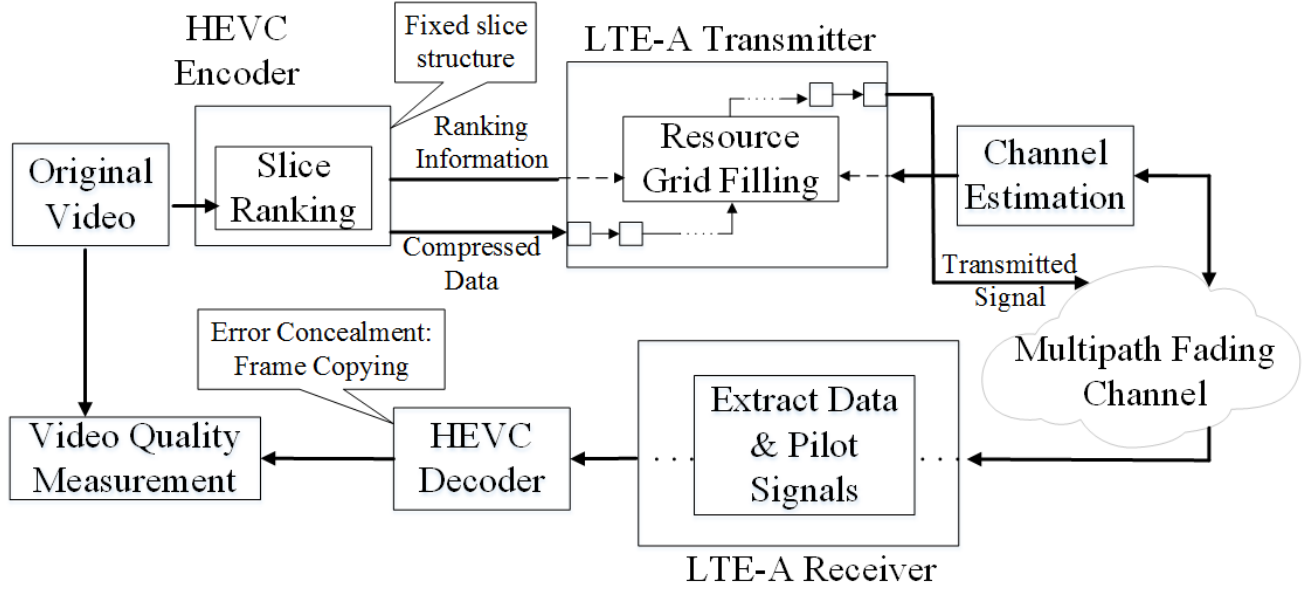
Figure 2. The proposed